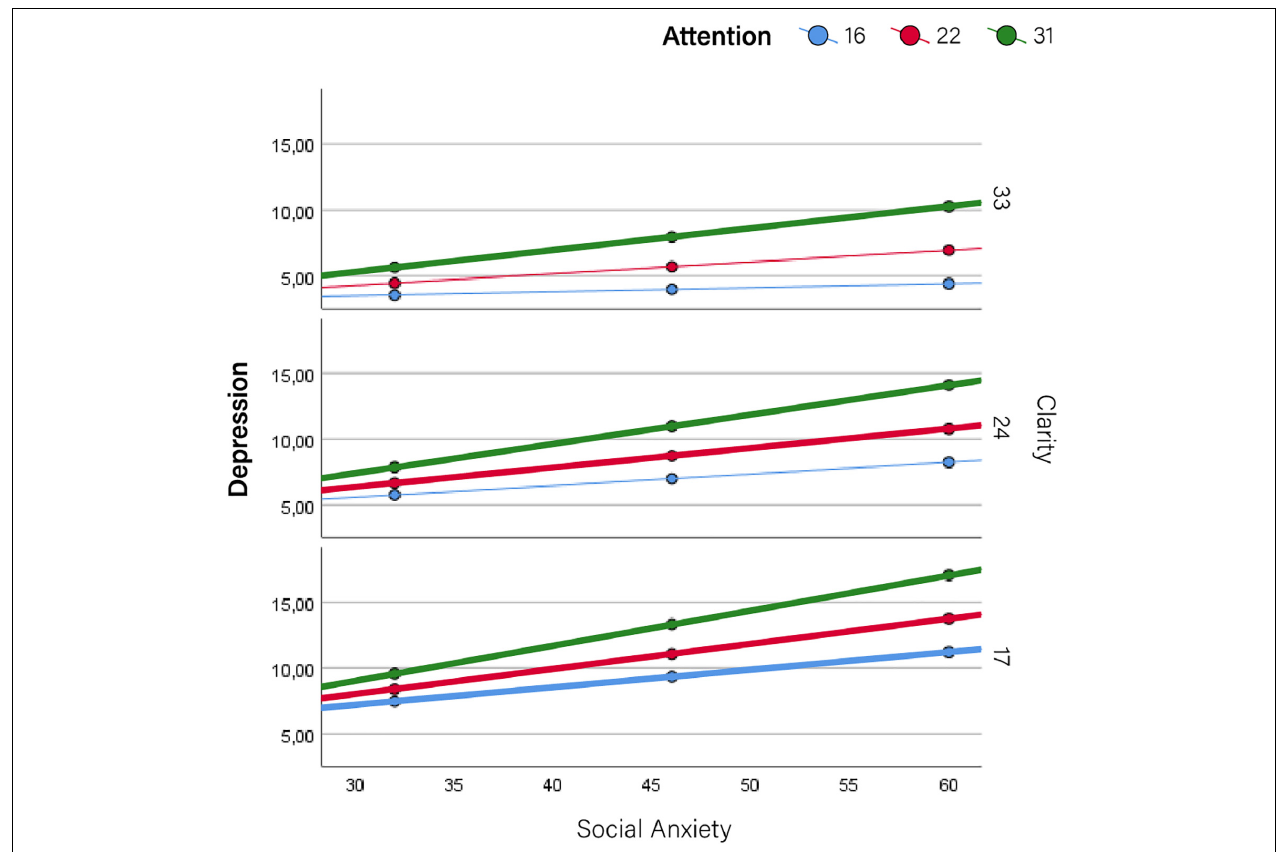
FIGURE 5 | Moderator effects of self mentalizing dimensions on depression. Conditional effects of social anxiety on depression at different levels of attention to emotions and emotional